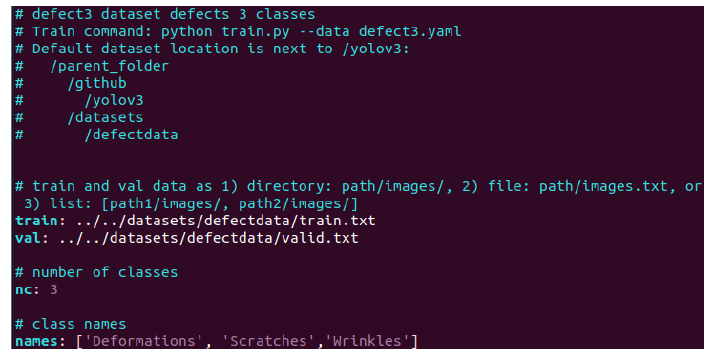
Figure 6. The yaml file.